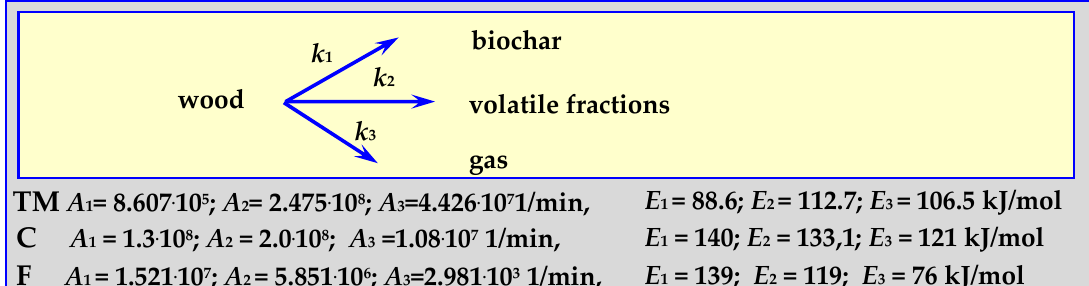
Figure 11. The mechanism of three phases of wood pyrolysis.